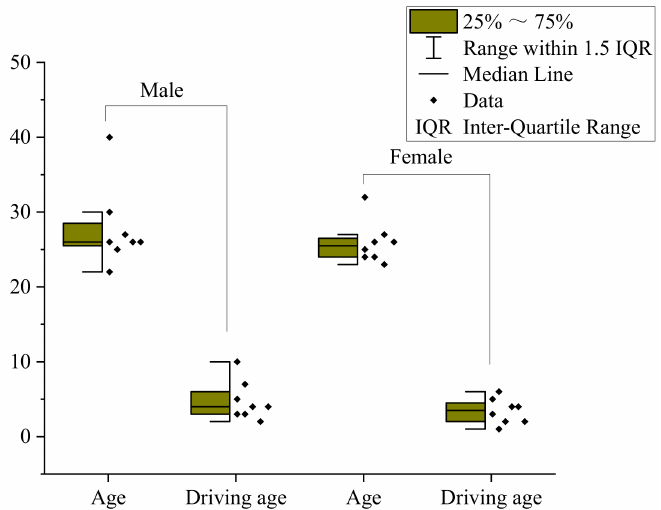
Figure 5. The subjects’